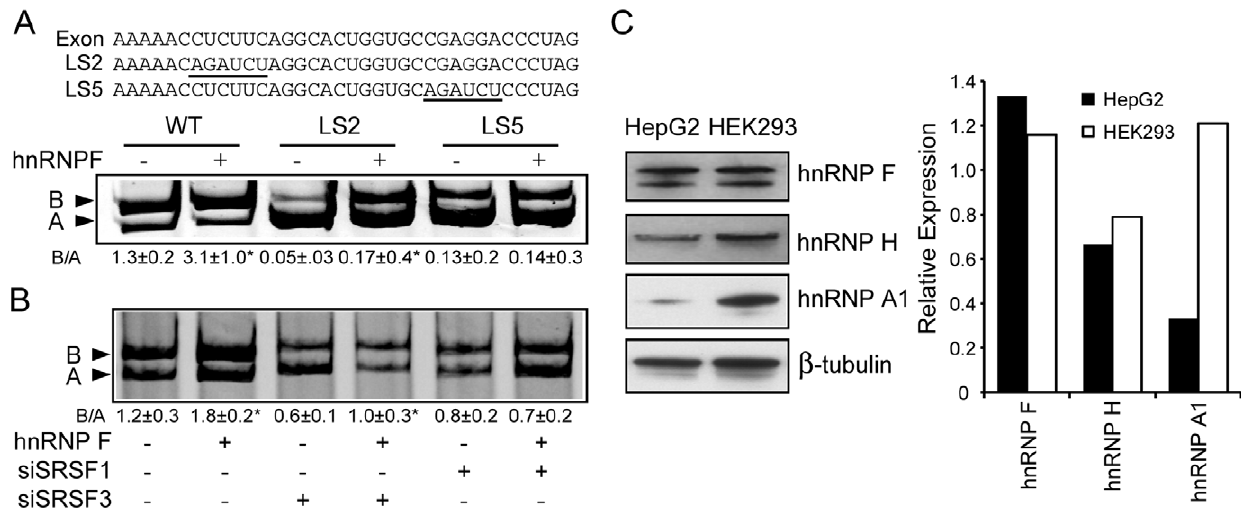
Figure 6. Functional dependence of hnRNP F on SRSF1. Panel A: Co-transfection of wild-type and the linker scanning mutants LS2 or LS5 with or without expression plasmid of hnRNP F. Sequence of the wild-type exon and the LS2 and LS5 mutants are shown underlined. Panel B: Co- transfection analysis in HepG2 cells with or without the over expression of hnRNP F in the presence of siRNA against endogenous SRSF3(SRp20) or SRSF1(SF2/ASF). Total RNA was isolated 48h after co-transfection. The relative expression level of the IR isoforms was measured and analyzed as described previously. The ratio of isoform B over isoform A of n=3 experiments with 6 standard deviation is shown. Asterisks indicate statistical significance vs. vector alone (* p # 0.05, **p # 0.01). Panel C: Total protein was extracted from HepG2 and HEK293 cells. Equal amounts of protein were loaded and immunoblotted for hnRNP A1, F, H, or b -tubulin as a loading control. Graph shows relative expression normalized to b -tubulin.